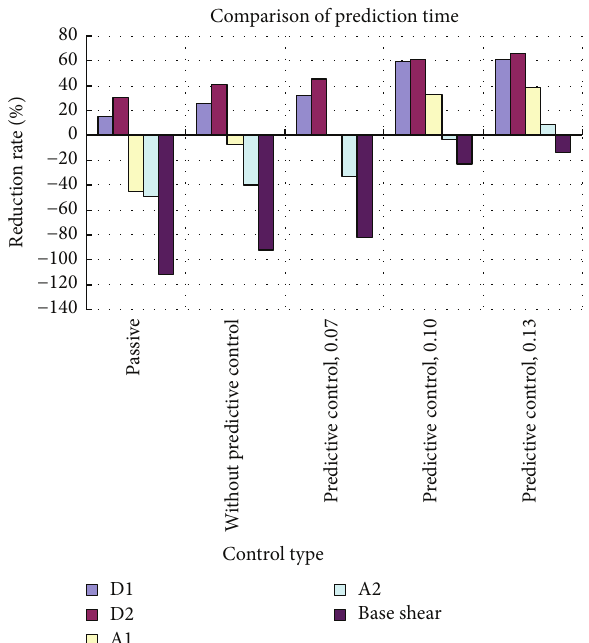
Figure 9: The average shock absorption ratios of the test structure with various control conditions under excitation of the Kobe